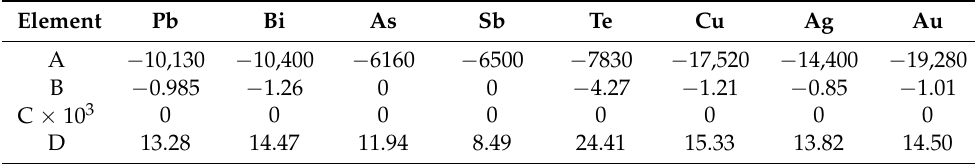
Table 2. Evaporation constants of each component in